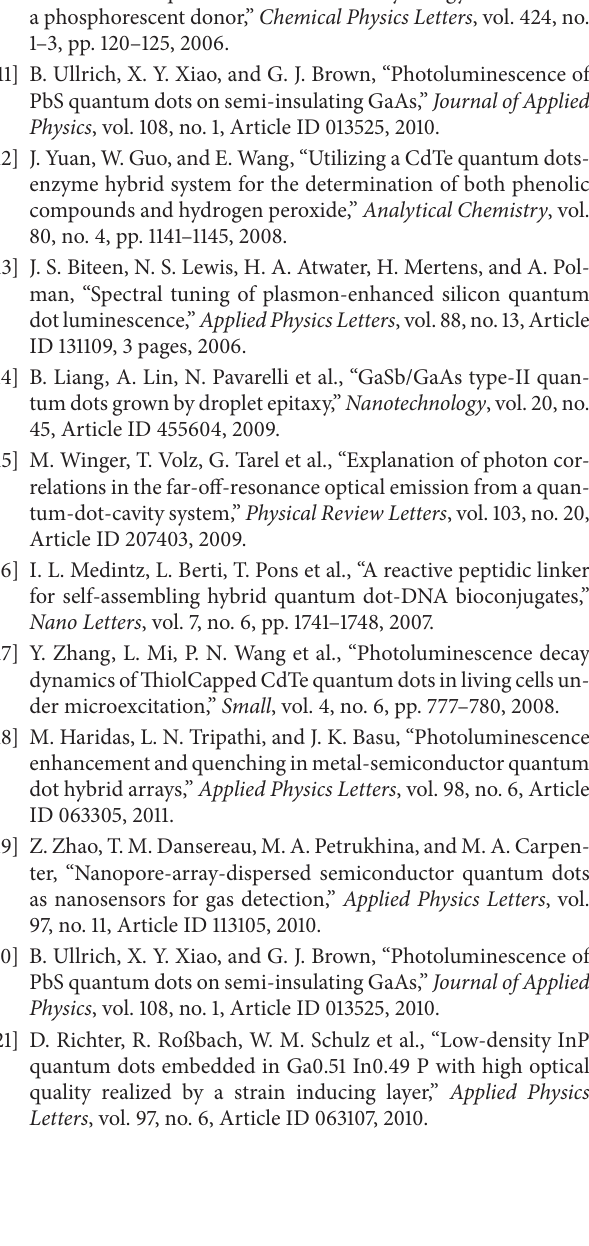
Table 2: AFM test data of monolayer and composite